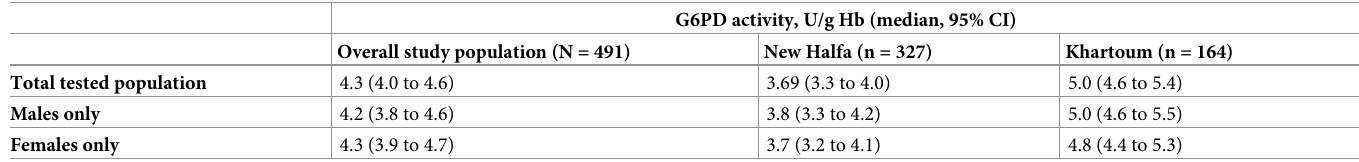
Table 2. Summary of G6PD activities (with 95% CIs) by biochemical testing, total study population, and in New Halfa and Khartoum,